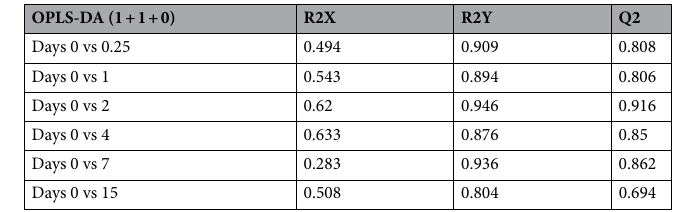
Table 1. Statistical parameters of supervised OPLS-DA models comparing time 0 with each of the considered times. R2X and R2Y indicate the fraction of variance of the X and Y matrix, respectively. Q2 is a goodness of prediction parameter representing the portion of the variance in the data predictable by the model.